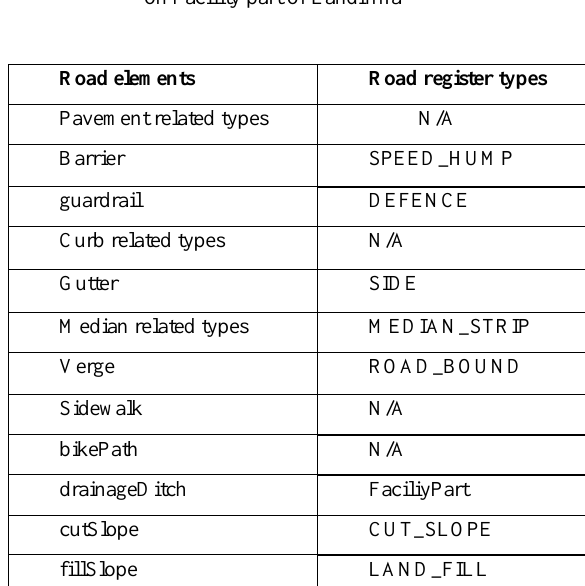
Figure 4. Proposed data model of the road register based on Facility part of